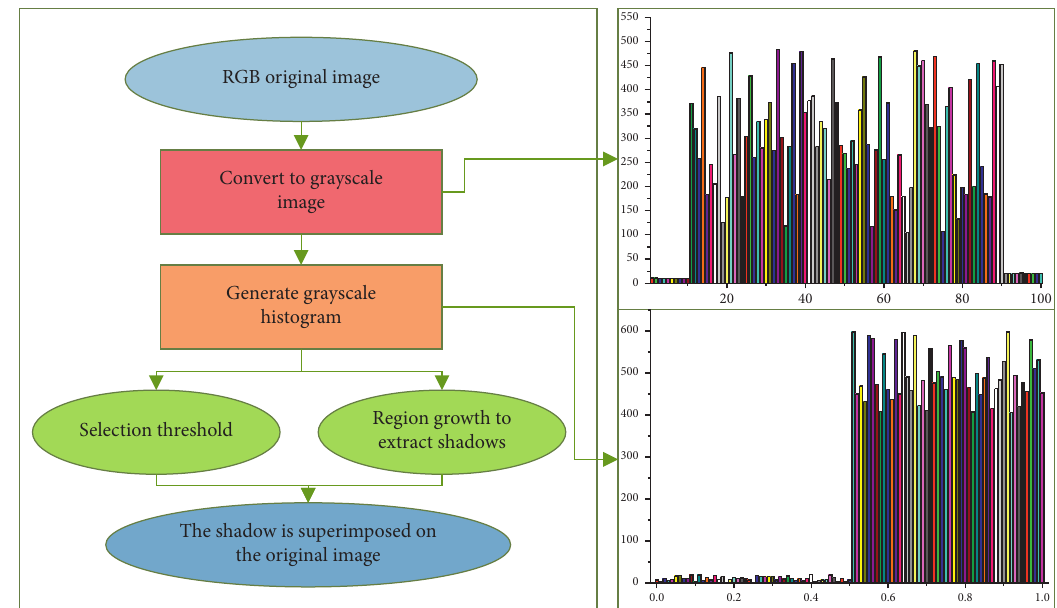
Figure 2: Area growth method